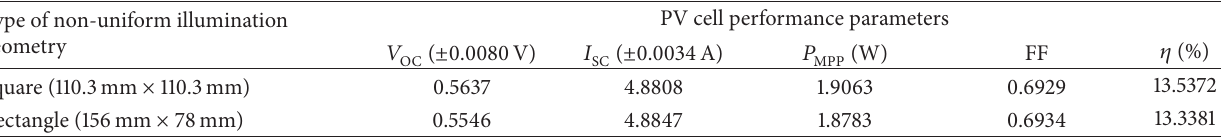
Table 6: The effect of non-uniform illumination geometry on the performance of a single cell at low energy concentration ratio. In each case, the level of non-uniform illumination was 50% of the total cell area.